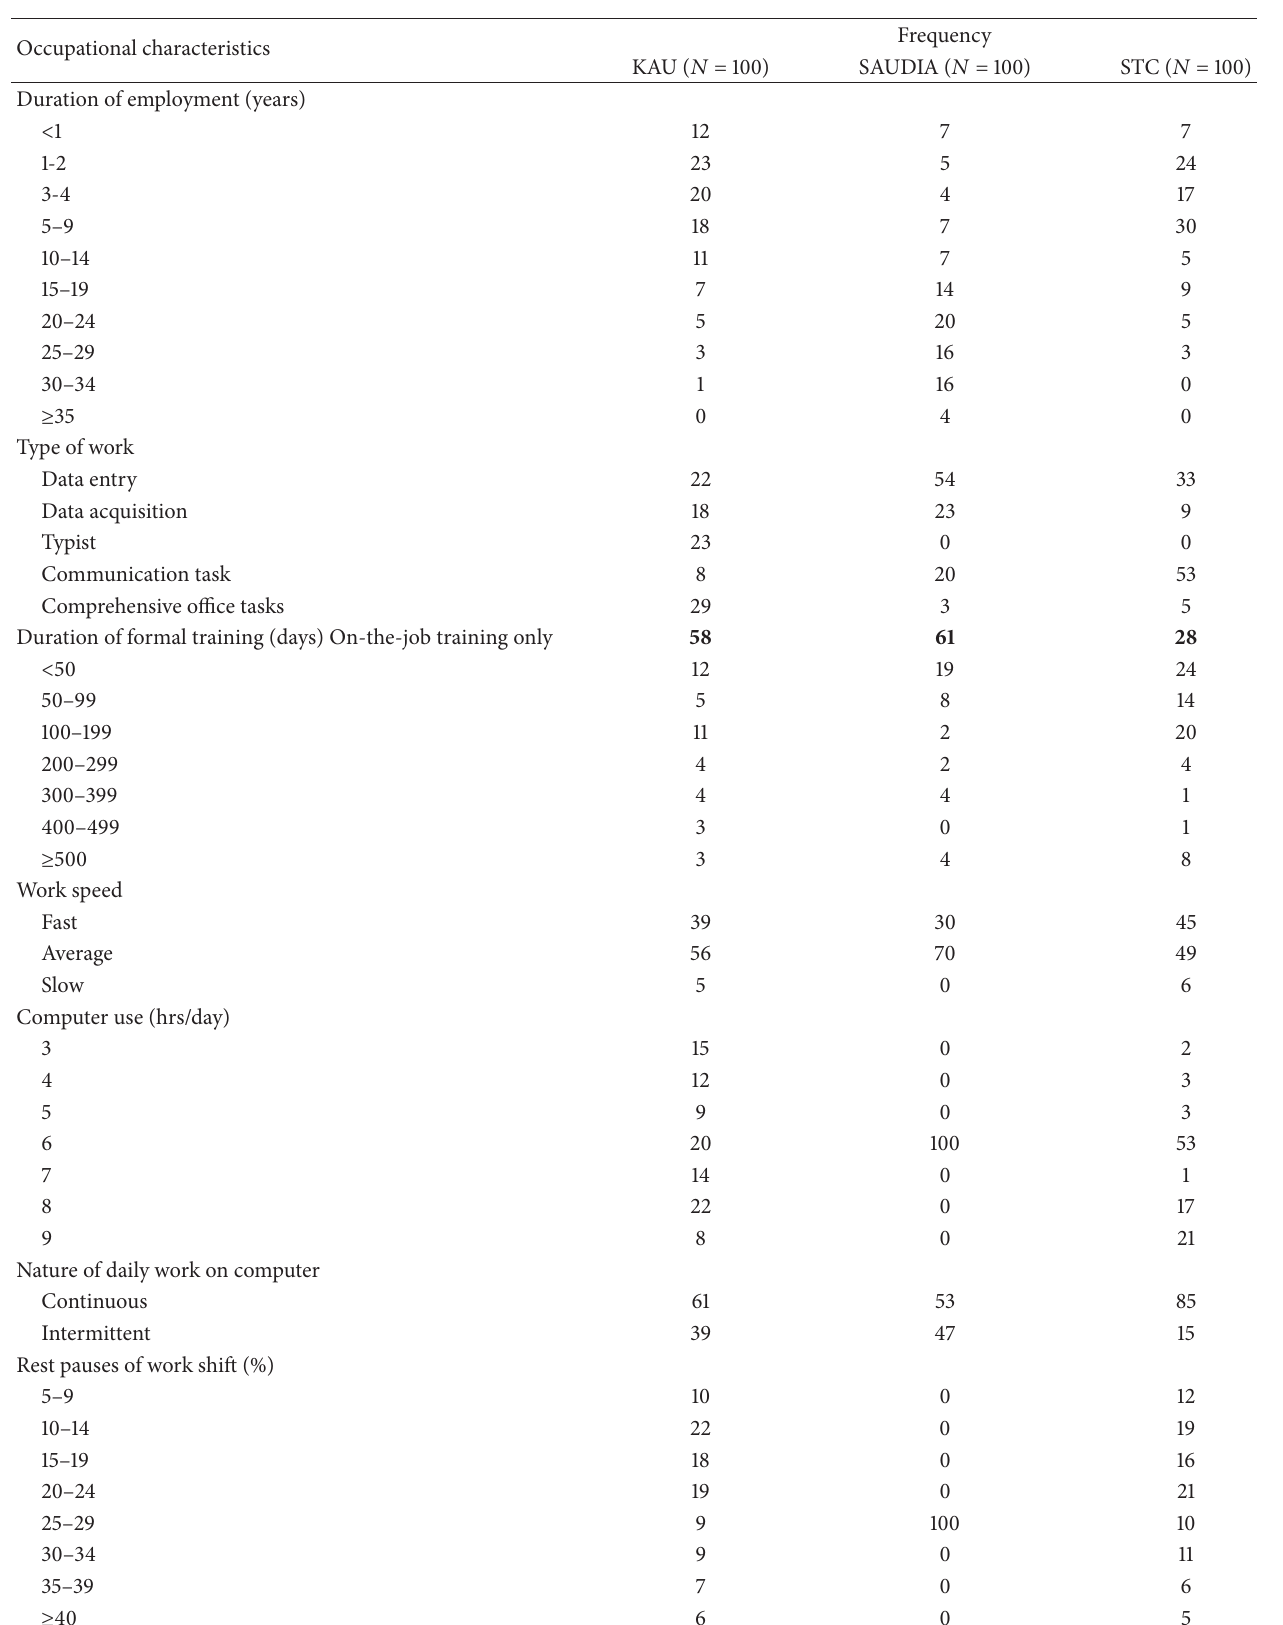
Table 5: Occupational characteristics of the study